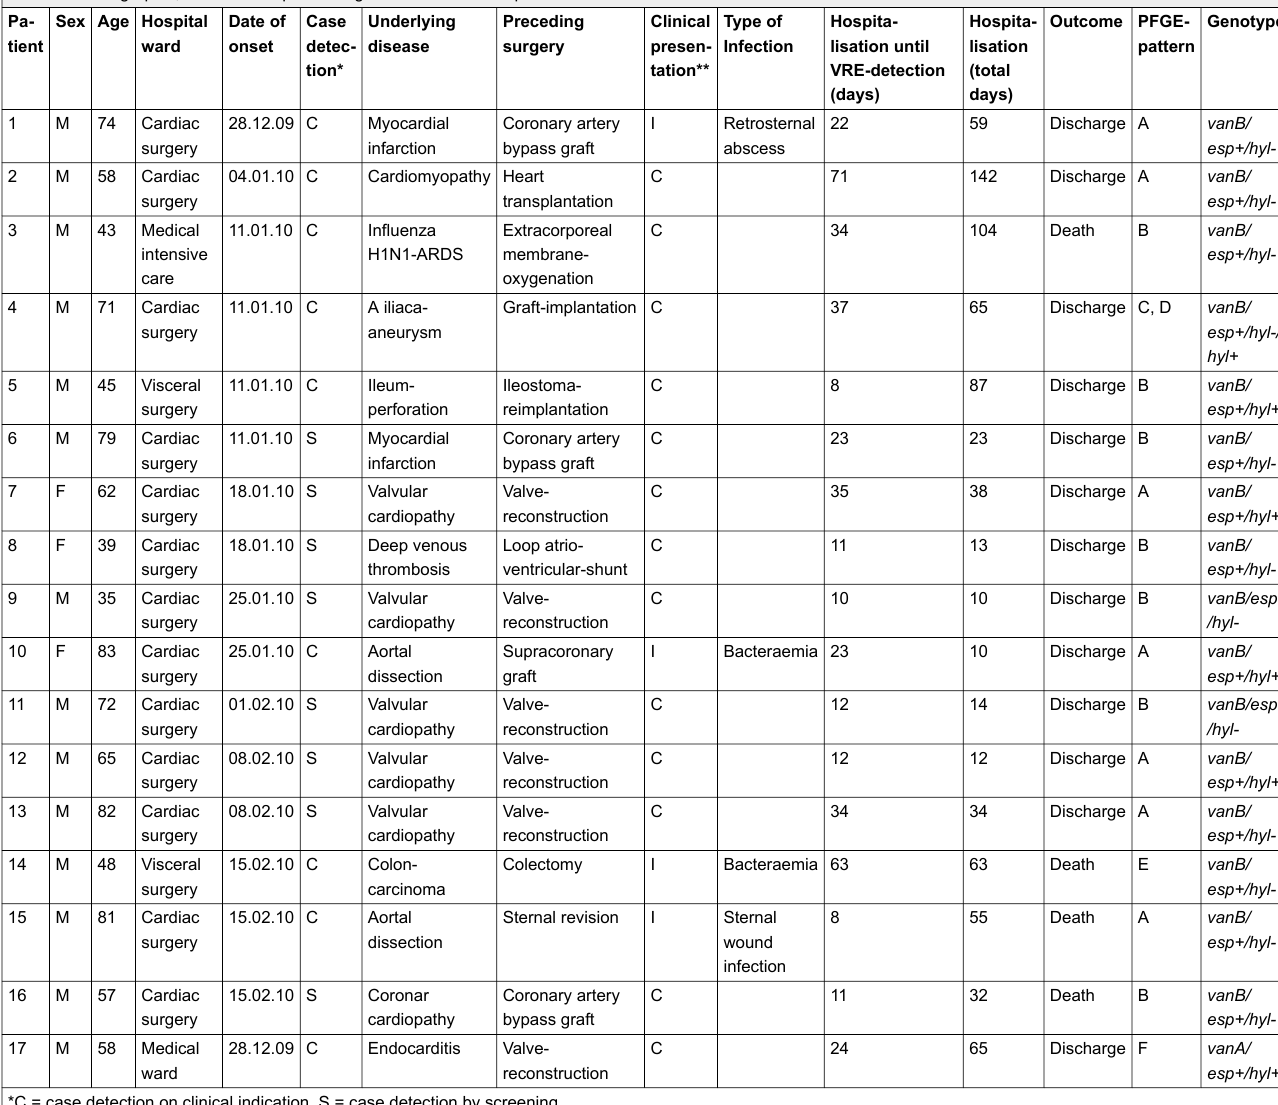
Table 1: Demographic, clinical and epidemiological data of affected patients. Pa- Sex Age Hospital tient